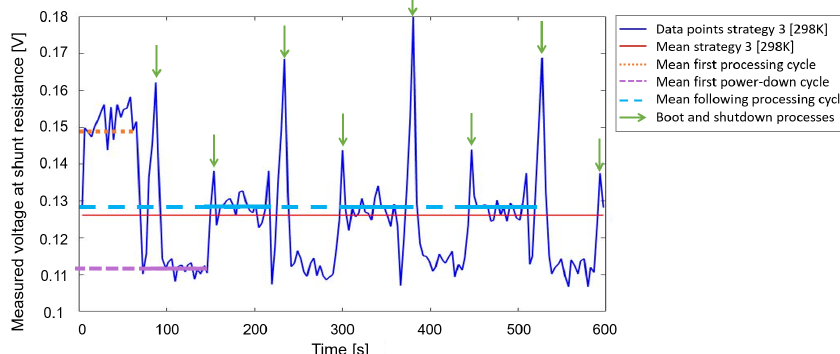
Figure 7. Operation strategy 3 at microcontroller 1.